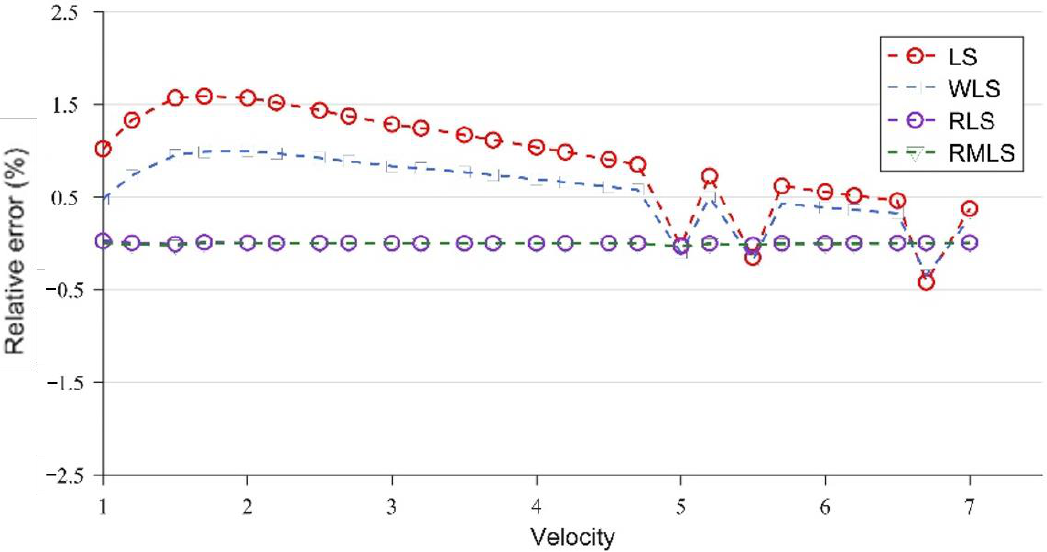
Figure 8. Results of LS, WLS, RLS, and RMLS with noise at x = 15 cm.